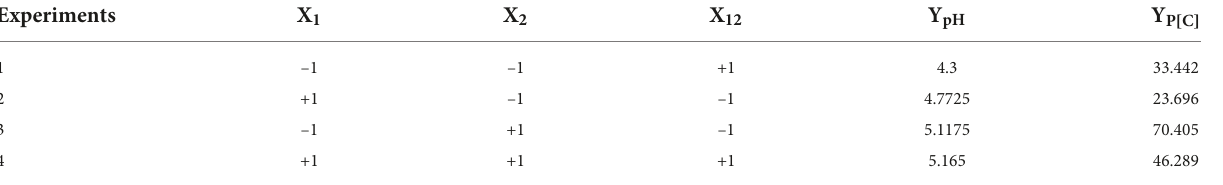
TABLE 6 Experimental design results done after P solubilization by isolate